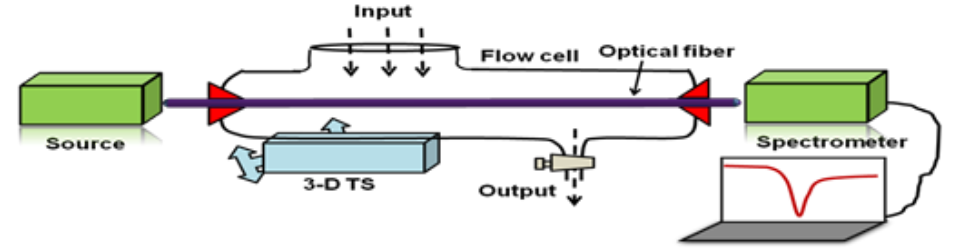
Figure 8. Generic experimental arrangement for fiber optic SPR sensor utilizing MIP as analyte recognition layer.